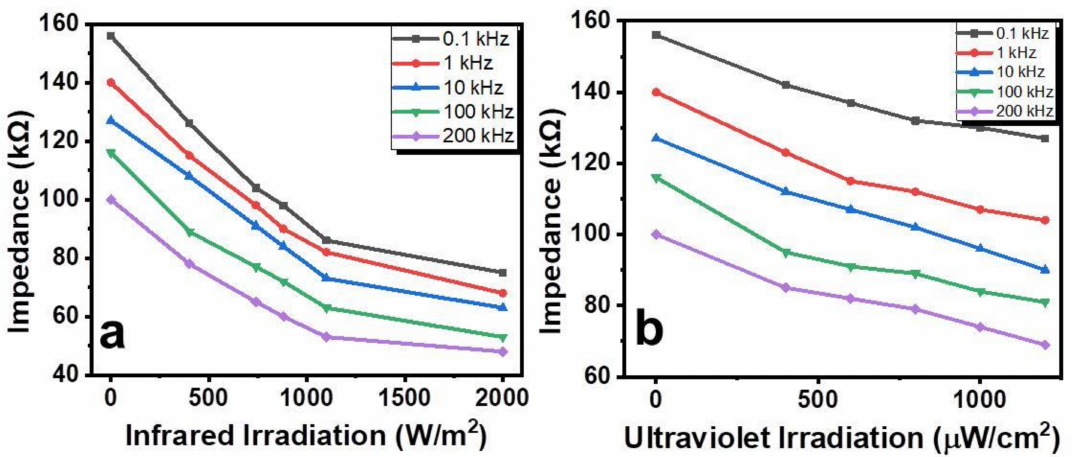
Figure 4. Dependence of the Al/OD-Gel/Cu cells impedance on different frequencies under the infrared ( a ) and the ultraviolet ( b ) irradiation.